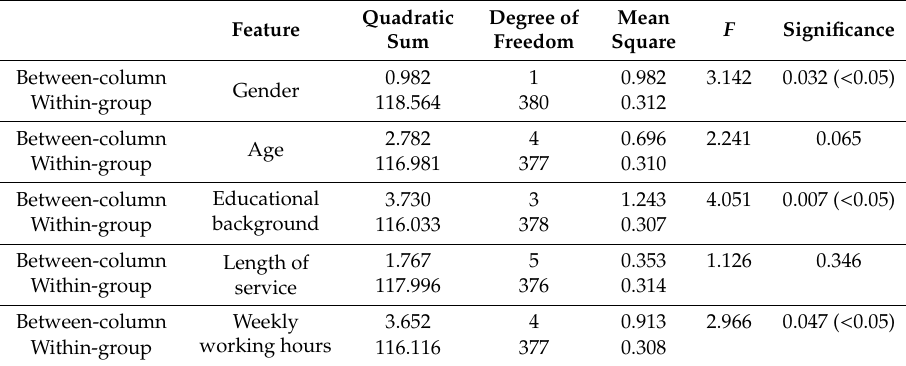
Table 15. Results of ANOVA in terms of demographic